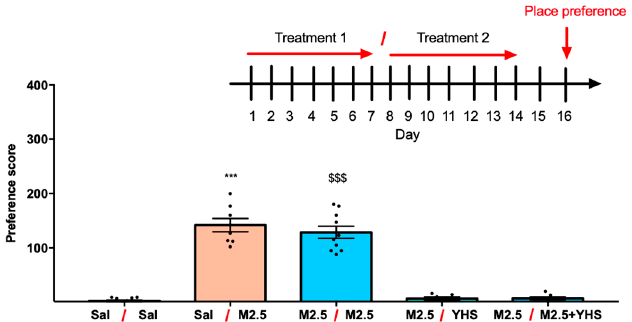
Figure 6. YHS reverses morphine-induced CPP. CPP responses for the following groups: 14 days of Sal injections (Sal–Sal), 7 days of Sal followed by 7 days of M2.5 injections (Sal-M2.5), 14 days of M2.5 injections (M2.5-M2.5), 7 days of M2.5 followed by 7 days of YHS (250 mg/kg) or M2.5-YHS injections (i.p. administration). (n = 7–11). The black dots correlate to the number of animals used in each experiment. One-way ANOVA revealed significant drug preference F = 8.131 p < 0.0001, followed by Tukey’s multiple comparison test, *** p < 0.0001 compared with Sal and M2.5-YHS, $$$ p < 0.0001 compared with Sal-Sal, M2.5-YHS, and M2.5-M2.5+YHS.